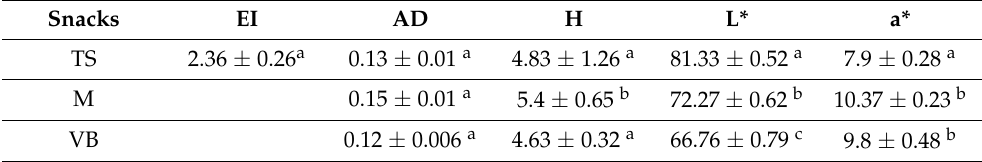
Table 9. Results of the analysis of commercial